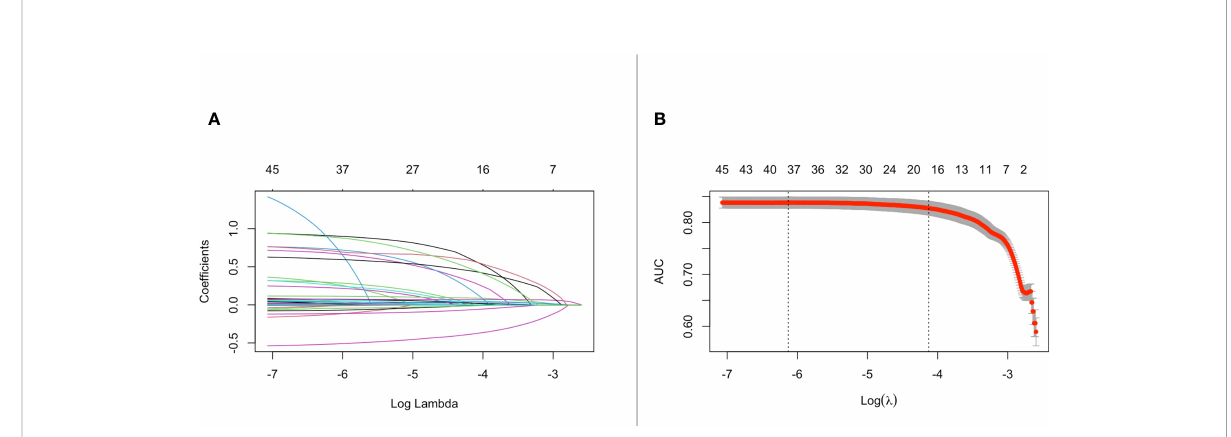
FIGURE 2 The change of the coef fi cient of different variables with penalty parameter l set (A) . Penalty parameter plot (B)